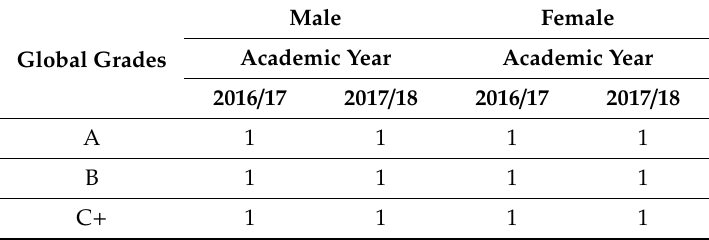
Table 1. Characteristics of the Physical Education Teacher Education (PETE) students